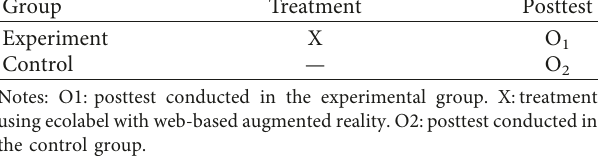
Group Treatment